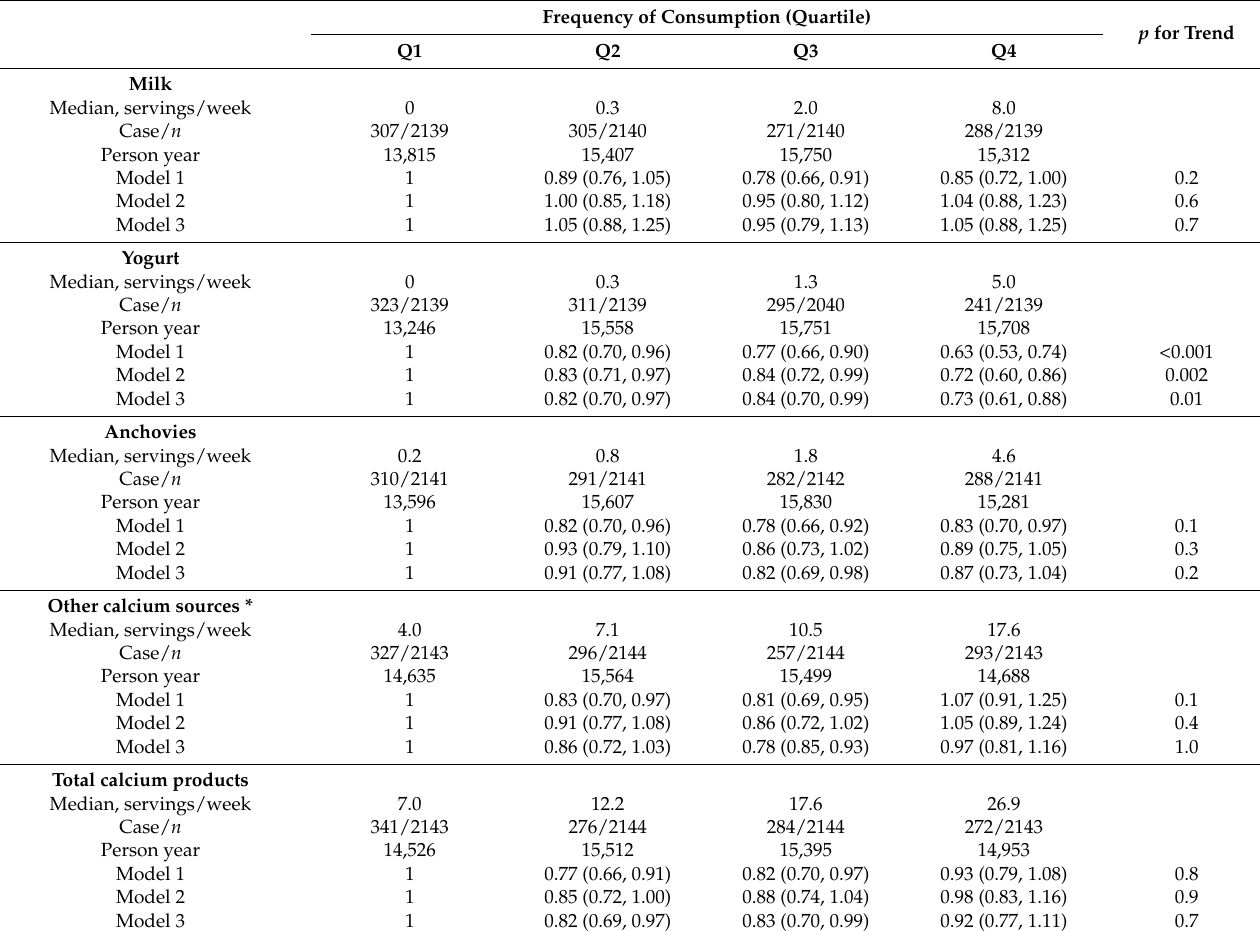
Table 2. Hazard ratio (95% confidence interval) for diabetes risk according to energy-adjusted calcium product intake